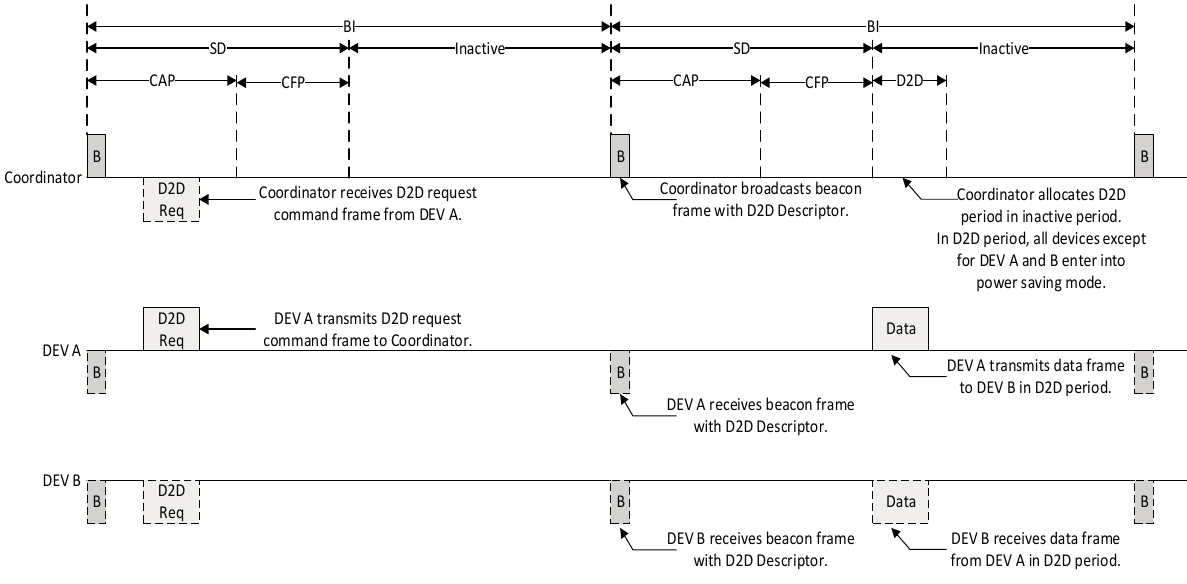
Figure 12. The flow of data frames and resource allocation in the proposed